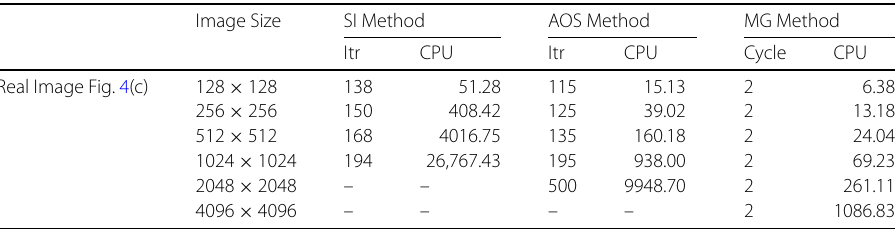
Table 2 Comparison of the proposed multigrid method (4.3) with SI (4.1), AOS (4.2) in terms of iterations and CPU time for an image with different